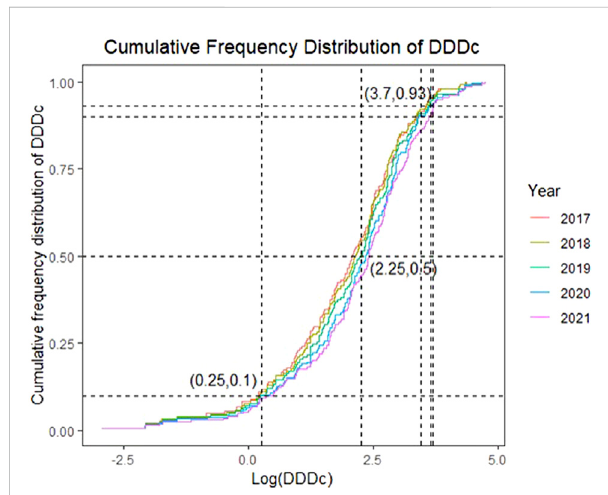
FIGURE 3 Cumulative Frequency Distribution of the Cost of De fi ned Daily Dose (DDDc) from 2017 to 2021 (in log